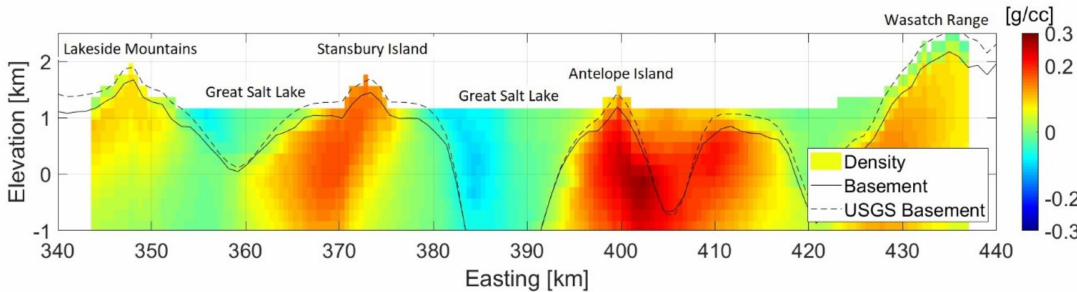
Figure 10. Vertical section along profile BB (cid:48) of 3D density model produced by the inversion with a priori density contrast model.